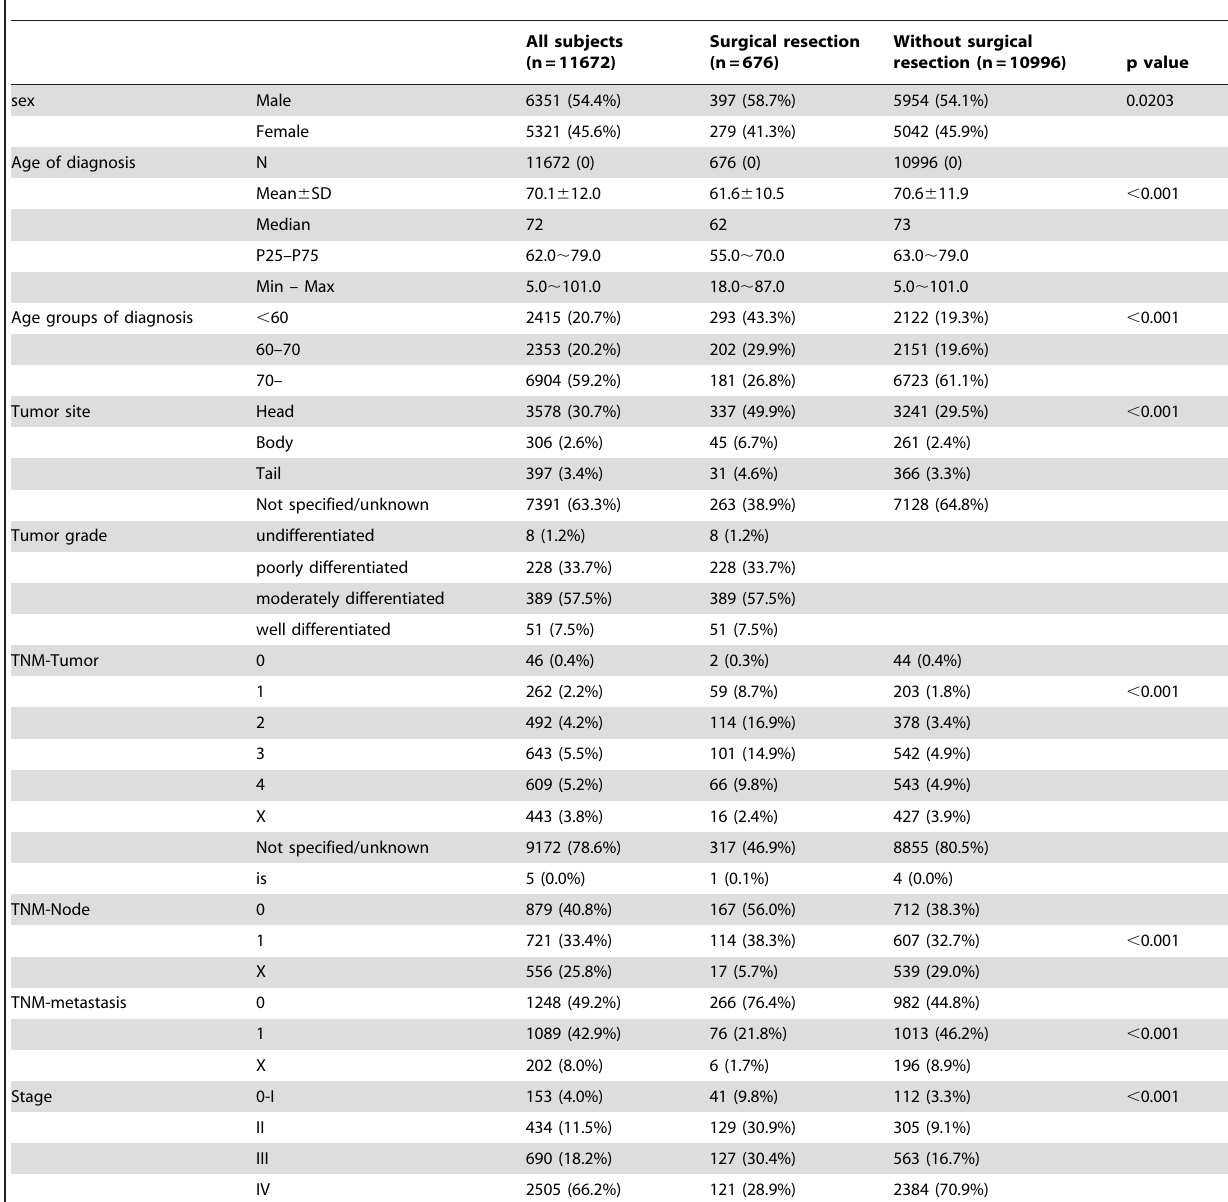
Table 2. Demographic factors, tumor characteristics of newly identified pancreatic cancer cases of Shanghai residency during